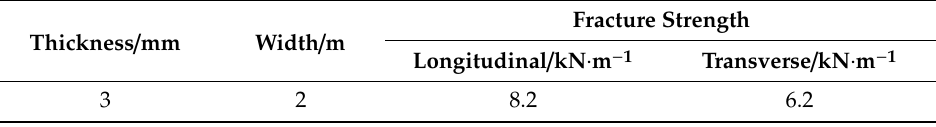
Table 3. Properties of controlled permeable formwork liner.